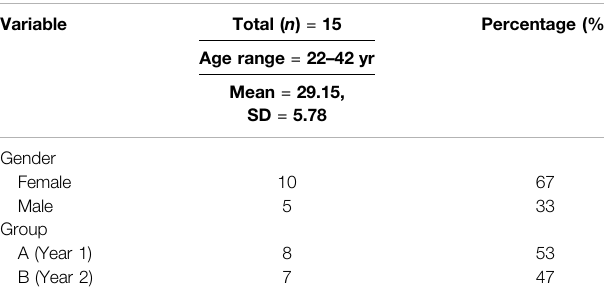
TABLE 2 | Participant demographic